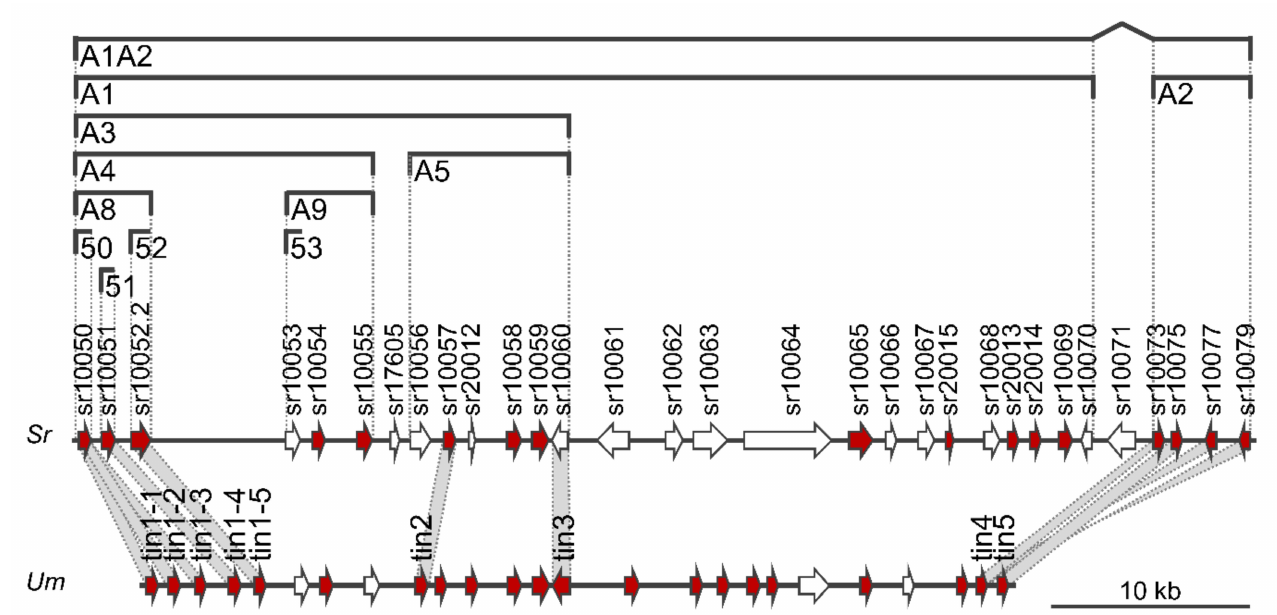
Figure 1. Map of divergence region 19-1 of Sporisorium reilianum including delineation of subcluster deletions and comparison to the gene cluster 19A of Ustilago maydis . Arrows indicate open reading frames. Genes predicted to encode secreted proteins (SignalP 6.0) are colored in red. Gene numbers from Genbank are indicated on top of each gene. Regions deleted in subcluster deletion strains are indicated by brackets. The name of the deletion is indicated below the bracket. Region 19-1 of S. reilianum ( Sr , top) is compared to cluster 19A of U. maydis ( Um , bottom [44]). Genes identified as virulence genes in U. maydis are named, and the homology of these genes to S. reilianum is indicated by grey